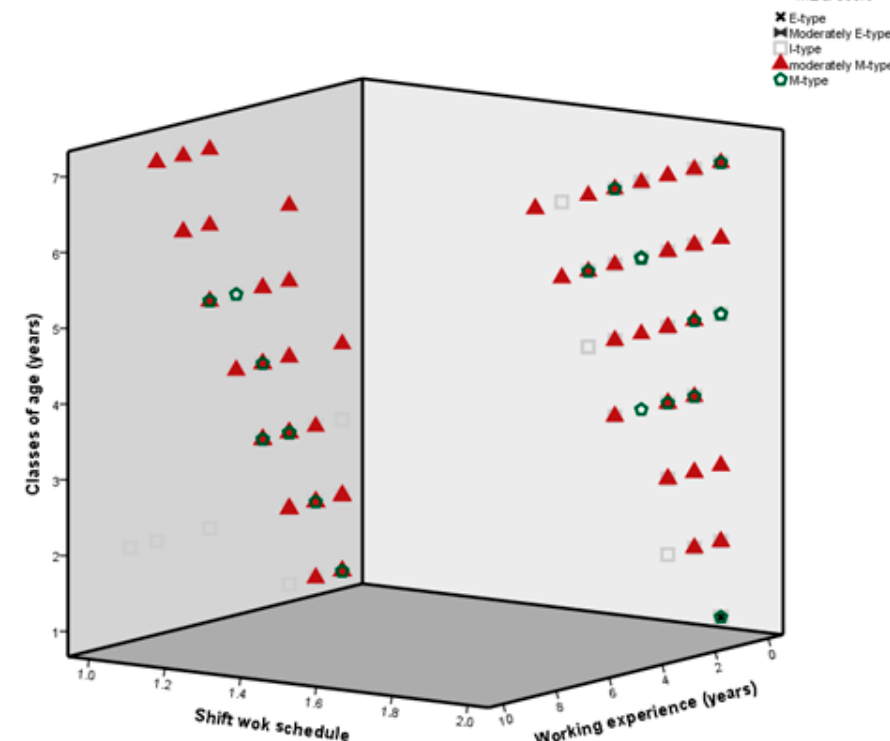
Figure 2. Cluster analysis relating age, shift work schedule, working experience, and MEQ score.